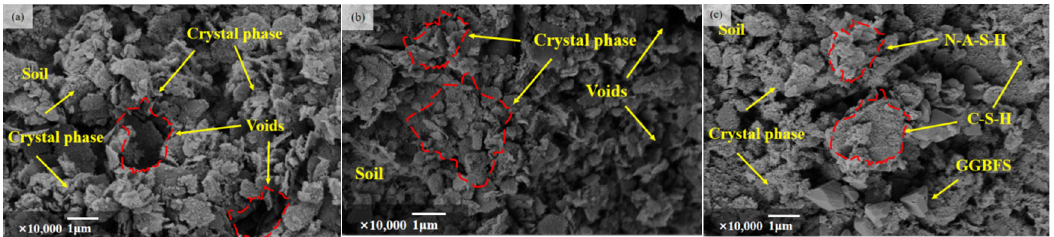
Figure 12. Electron microscope scans of the soft soil stabilized using different mixture ratios. ( a ) Activator modulus = 0.8, alkali content = 7%, slag = 30% geopolymer soil, ( b ) activator modulus =